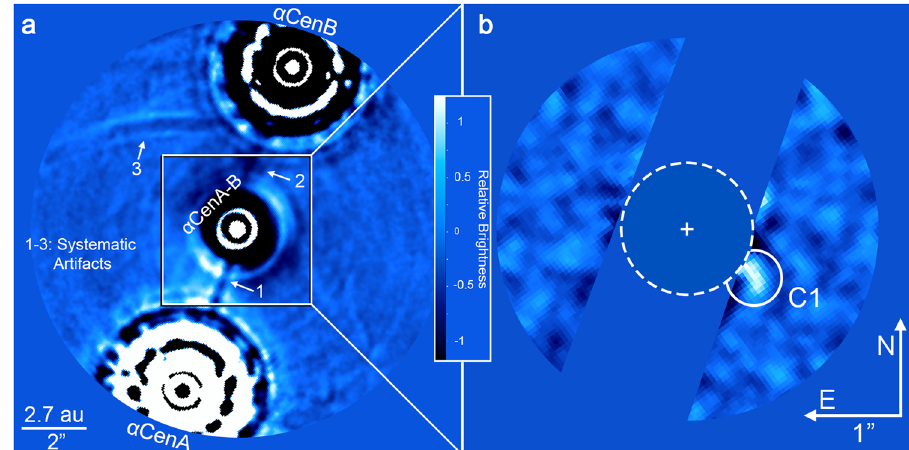
Fig. 2 Mid-infrared images of α Centauri. a high-pass fi ltered image without PSF subtraction or artifact removal. The α Centauri B on-coronagraph images have been subtracted from the α Centauri A on-coronagraph images, resulting in a central residual and two off-axis PSFs to the SE and NW of α Centauri A and B, respectively. Systematic artifacts labeled 1 – 3 correspond to detector persistence from α Centauri A, α Centauri B, and an optical ghost of α Centauri A. b Zoom-in on the inner regions following artifact removal and PSF subtraction. Regions impacted by detector persistence are masked for clarity. The approximate inner edge of the habitable zone of α Centauri A 13 is indicated by the dashed circle. A candidate detection is labeled as ‘ C1 ’